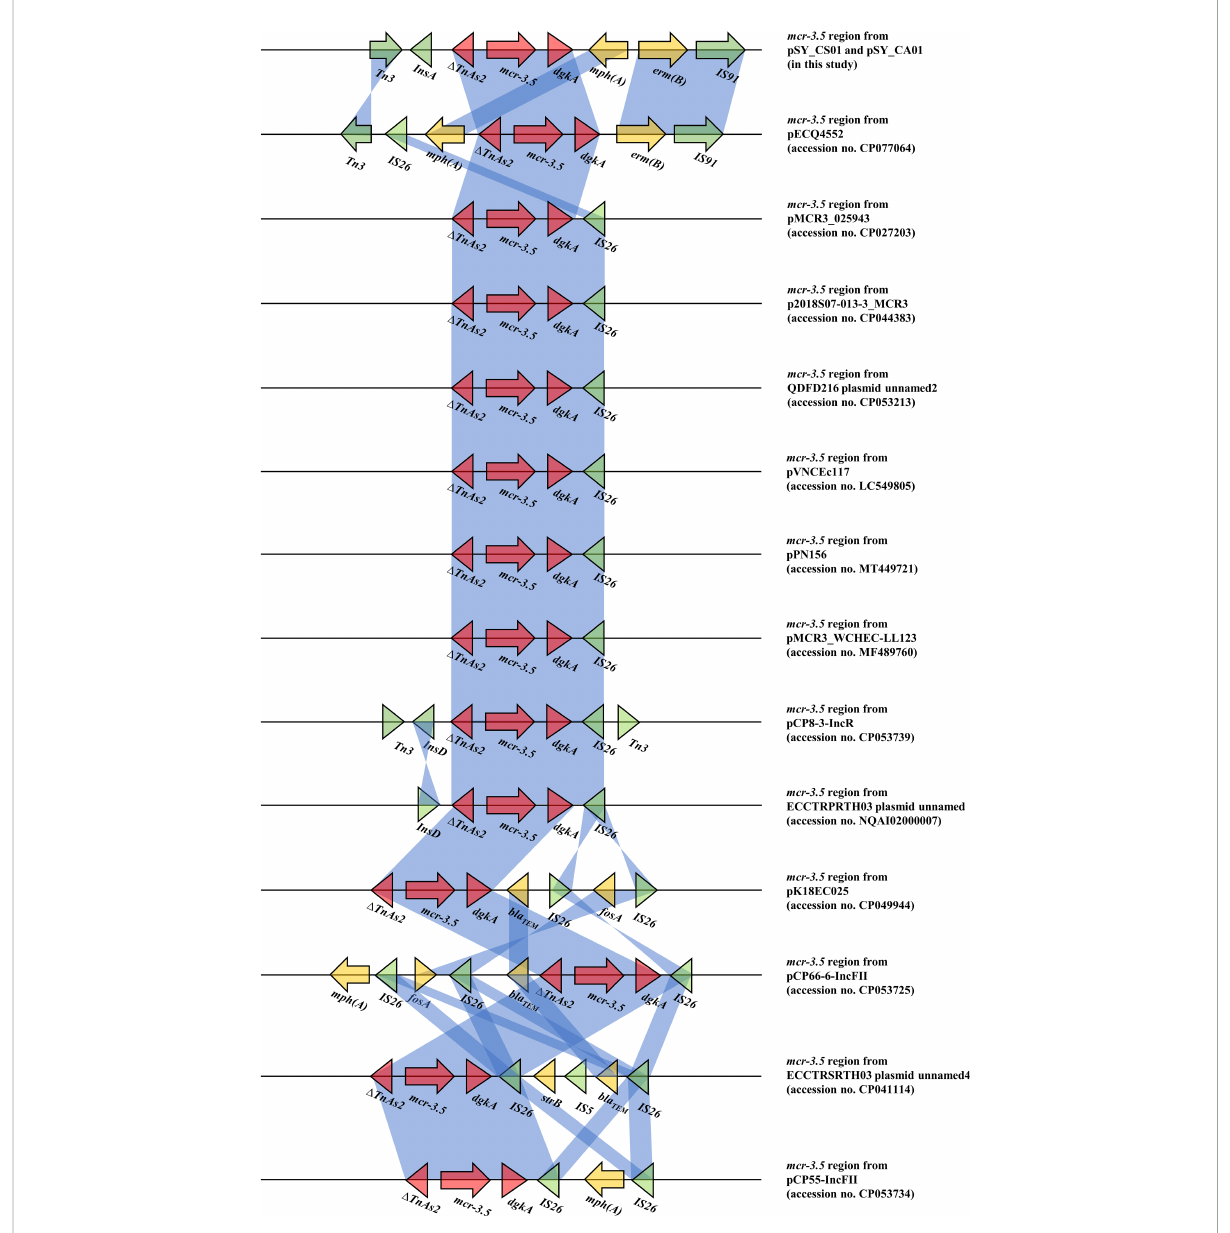
FIGURE 9 Comparison of 14 mcr-3.5 regions from 16 plasmids. The arrows indicate directions of gene transcription. Shading in light blue denotes regions of homology (nucleotide identity